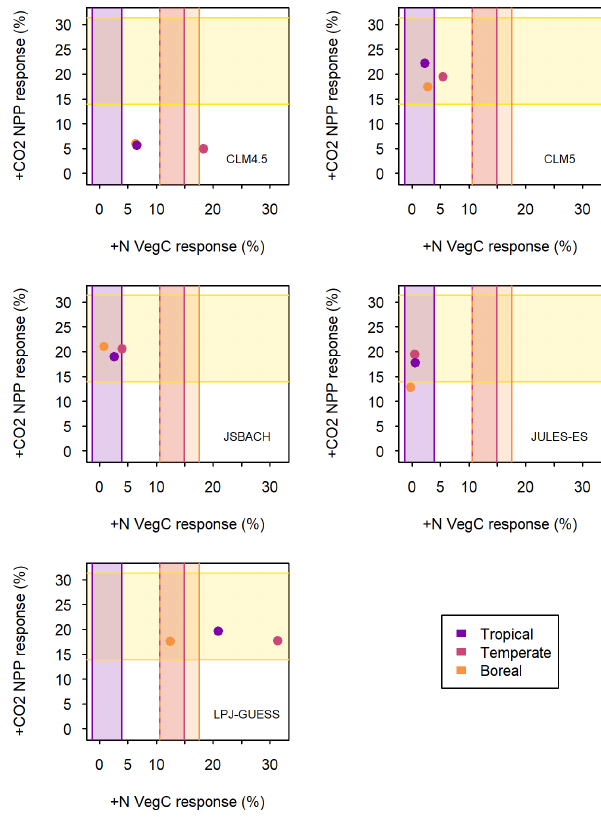
Figure 5. Average 1996–2005 model predictions of woody plant NPP responses to + CO 2 ( y axis) and above-ground forest vegeta- tion C pool size responses to nitrogen (N) addition ( x axis) for each of the models (as labelled). Area outlined in yellow indicates syn- thesis of observed woody plant NPP responses to + CO 2 (Baig et al., 2015). Other coloured areas indicate biome-wise estimates of above-ground forest C change per added N (Schulte-Uebbing and de Vries, 2018). For + CO 2 , NPP is restricted to simulated vegeta- tion with NPP > 0 . 2kgCm − 2 yr − 1 to exclude non-forest areas. For + N, forest VegC in CLM5, CLM4.5, and LPJ-GUESS is taken from wood C and N, whereas all C and N is included for JULES-ES and JSBACH due to model output limitations. The biomes are allocated according to the Köppen–Geiger climate classification (Kottek et al., 2006). The lower limits for “Temperate” and “Boreal” + N are the same